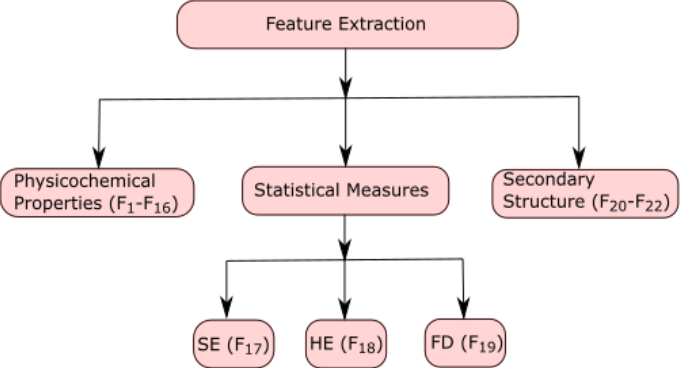
Figure 1. Characterization of features used to represent ALDH2 sequences. SE: Shannon entropy. HE: Hurst exponent. FD: fractal